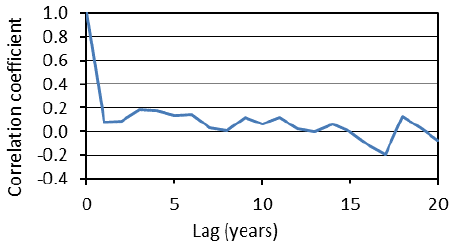
Figure 4. Correlogram of annual flow volume at Kassala Bridge (1907–2013).